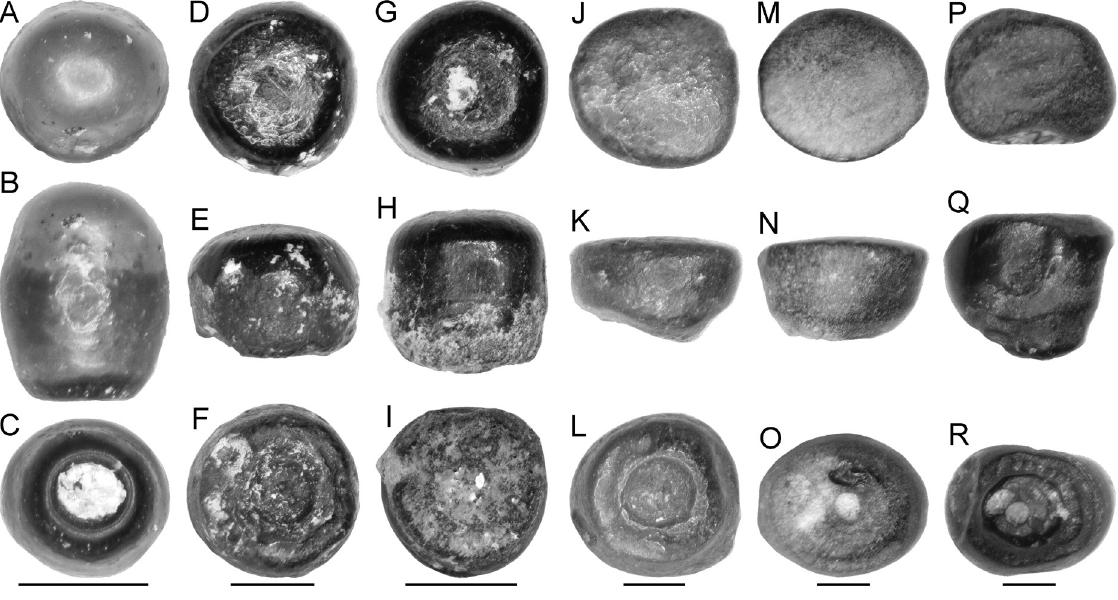
Fig. 60. Albula eppsi White, 1931 and Albula oweni (Owen, 1845), teeth. A–I . Albula eppsi A–C .